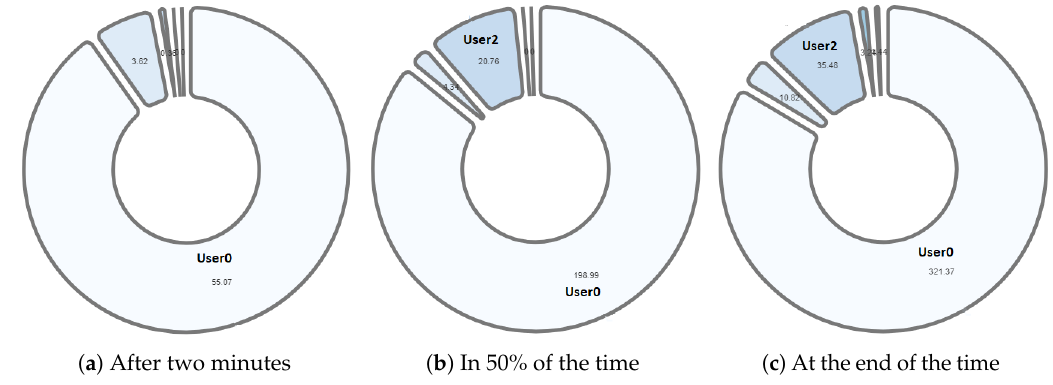
Figure 16. Pie chart with the evolution of G3 speech time